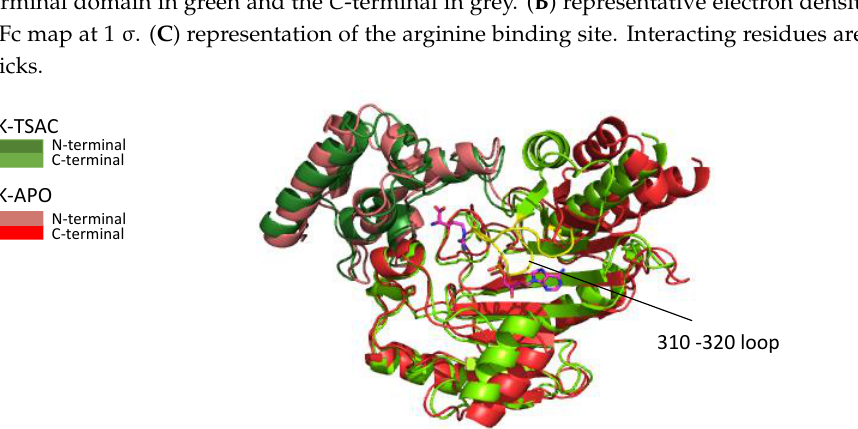
Figure 3. Structural overlapping of the experimental structure Rs AK apo (in red) with the theoretical Rs AK substrate/product (Arg-ADP) closed conformation model (in green), showing ADP and Arg substrates as sticks.